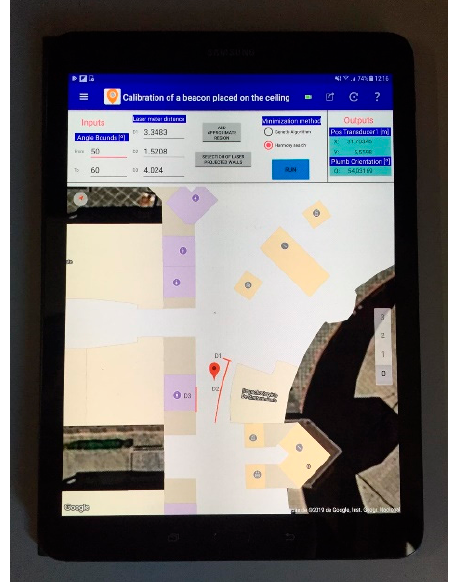
Figure 13. CDFs of the error related to the estimation of the positions for beacon #1 (left) and beacon #2 (right).